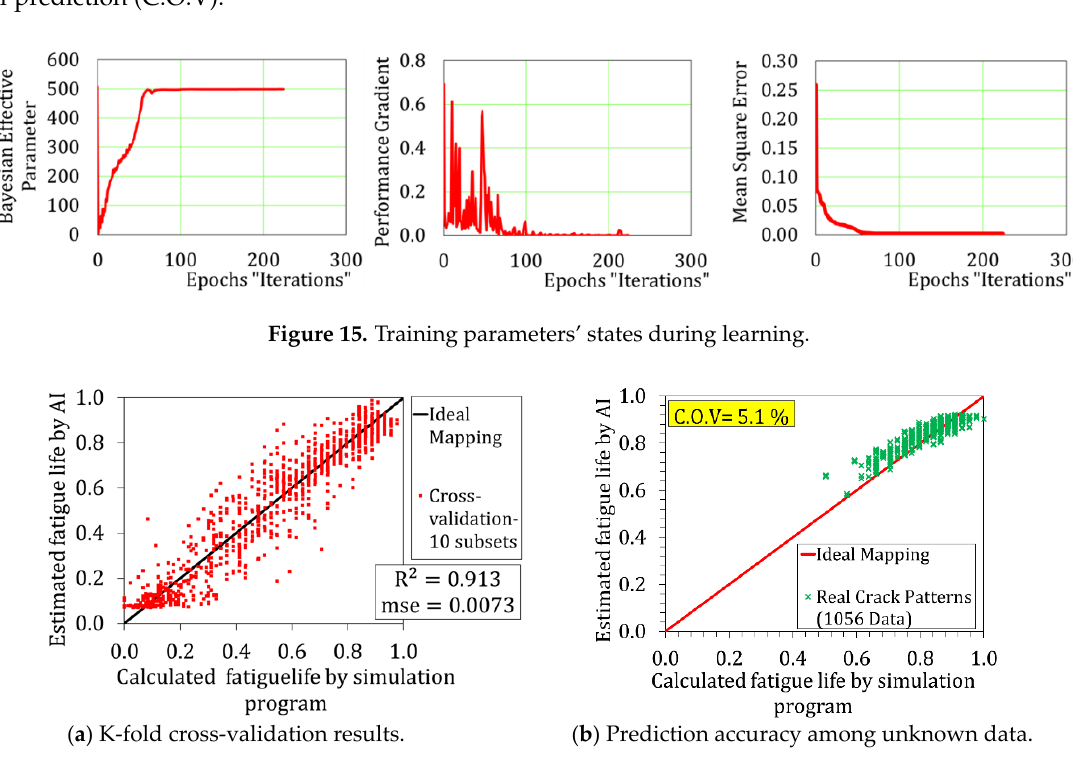
Figure 16. K-fold cross-validation & ANN’s robustness among unknown data.